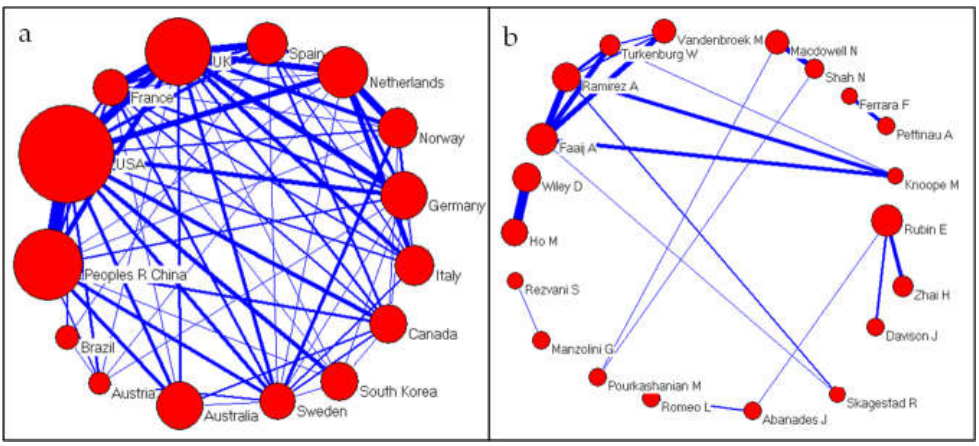
Figure 5. National ( a ) and auctorial ( b ) collaboration networks.